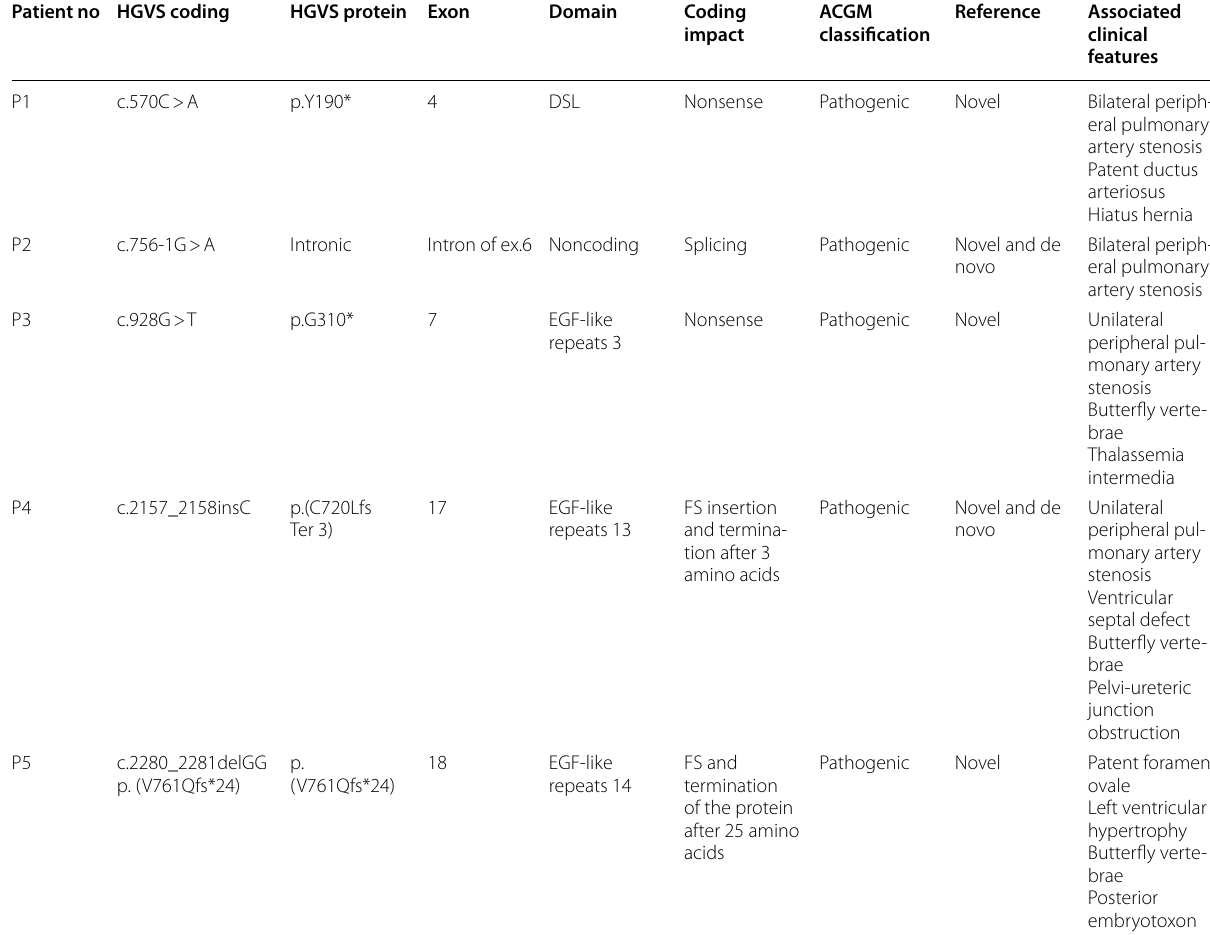
ACMG American College of Medical Genetics; DSL = Variation Society; P, patient; Ter, termination